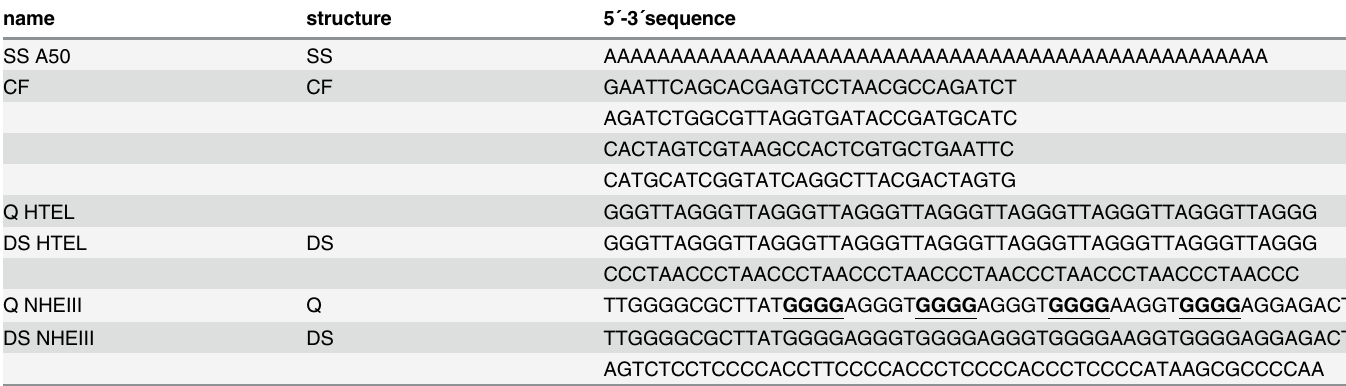
Table 1. DNA sequences of